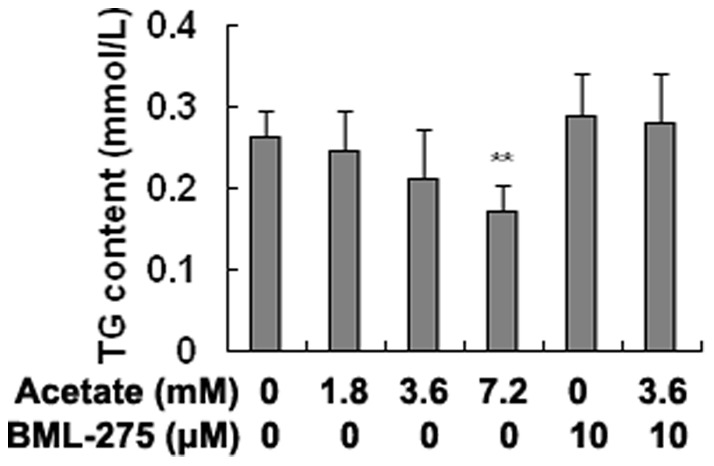
TG content in hepatocytes.Hepatocytes were treated with acetate and BML-275 and divided into a control group (0 mM acetate), a low-dose acetate treatment group (1.8 mM acetate), a medium-dose acetate treatment group (3.6 mM acetate), a high-dose acetate treatment group (7.2 mM acetate), a BML-275 group (10 μM BML-275), and a BML-275+acetate group (10 μM BML-275+3.6 mM acetate). Acetate (sodium acetate) was used in the form of neutralized acetic acid to avoid changing the pH of the medium. * p<0.05, ** p<0.01 versus the control group.